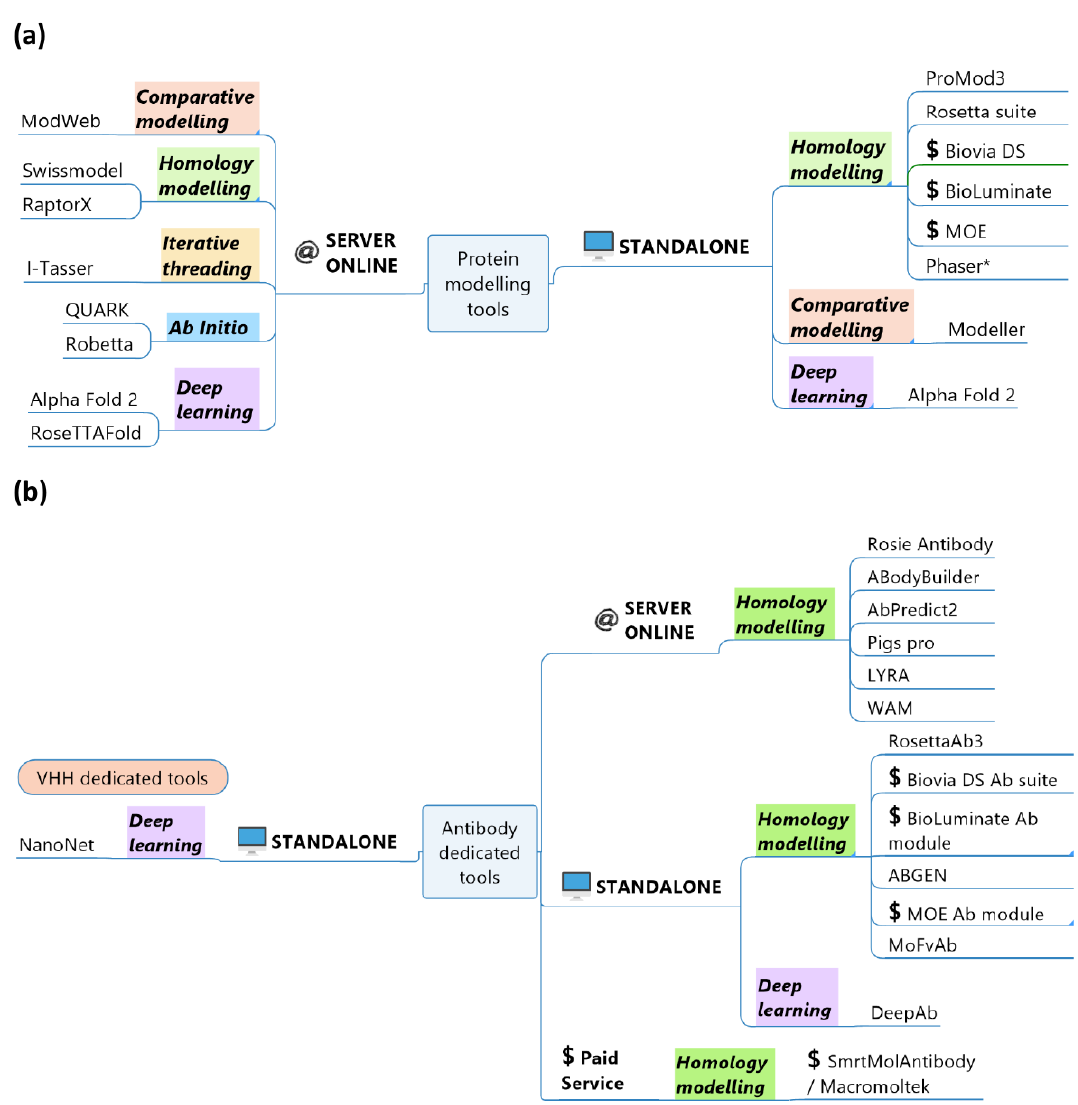
Figure 2. Protein structural prediction tools. The above representation is a summary of ( a ) general protein modelling tools and ( b ) Antibody and V H H modelling tools. All the tools are classified according to their availability (standalone and/or online server, academic or commercial) and the methodologies used (comparative/homology modelling, threading, ab initio and deep learning). * The phaser is dedicated to molecular replacement